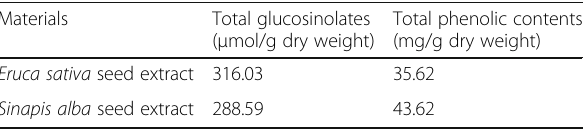
Table 6 Total glucosinolates ( μ mol/g dry weight) and total phenolic contents (mg/g dry weight) in the seed powder of both Eruca sativa and Sinapis alba Materials Eruca sativa seed extract